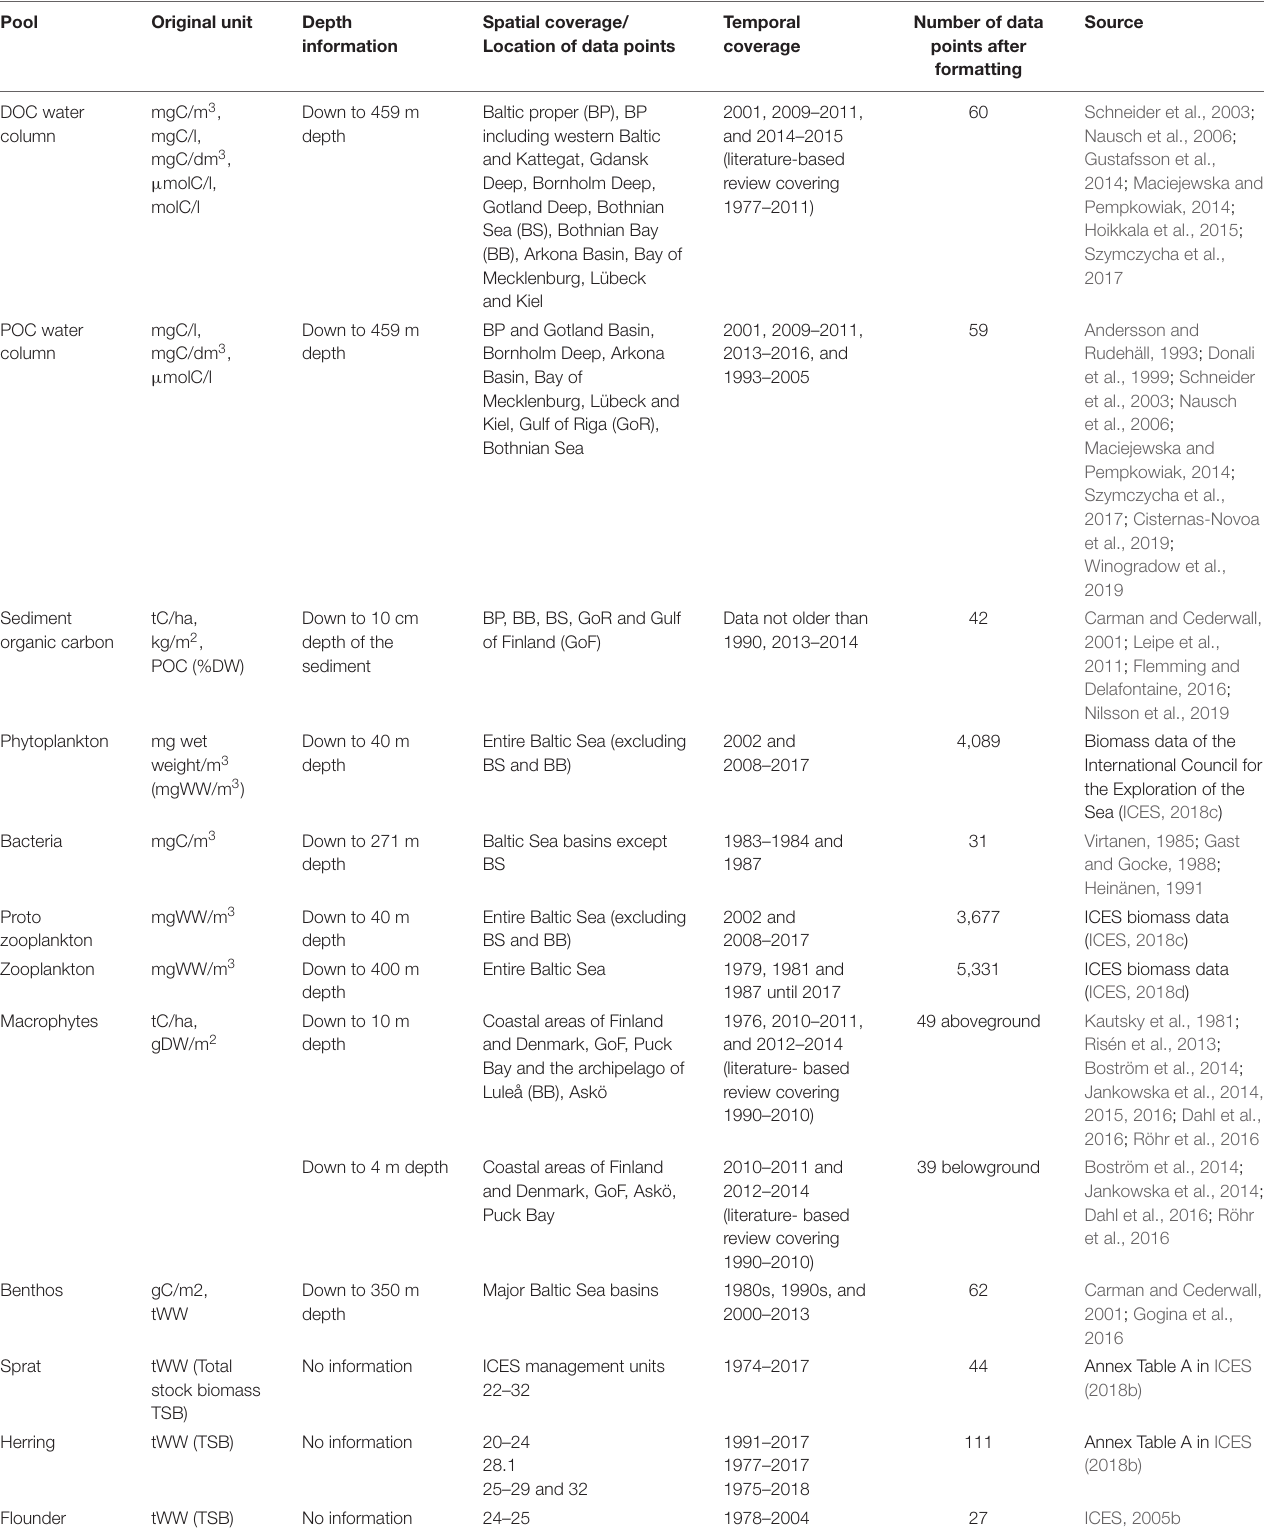
TABLE 1 | Data specifications of the original